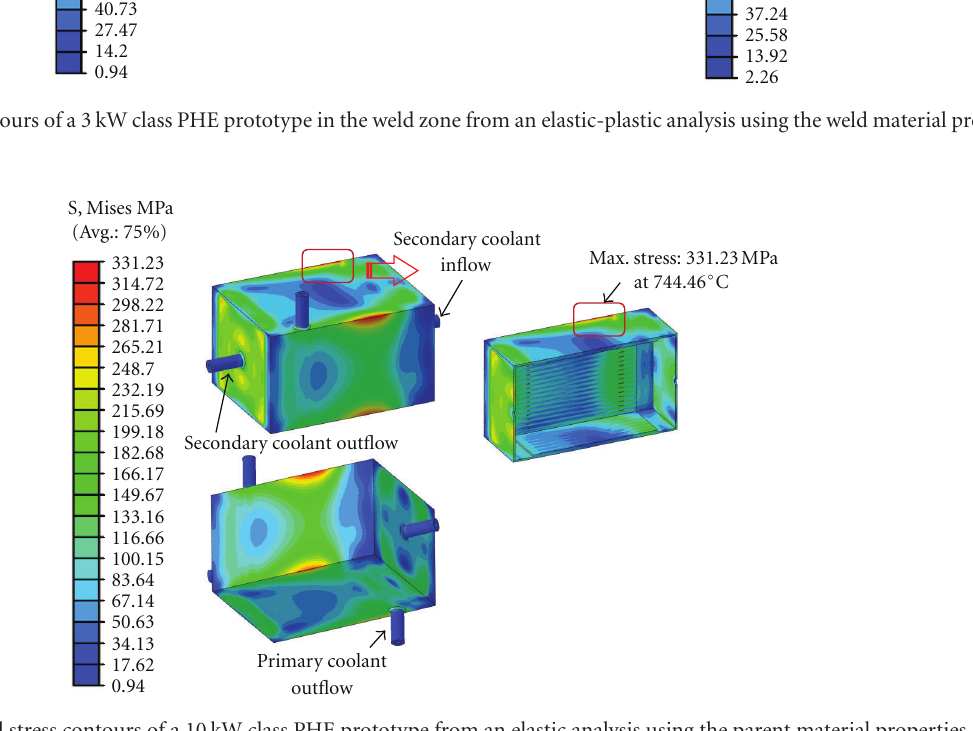
Figure 15: Overall stress contours of a 10kW class PHE prototype from an elastic analysis using the parent material properties